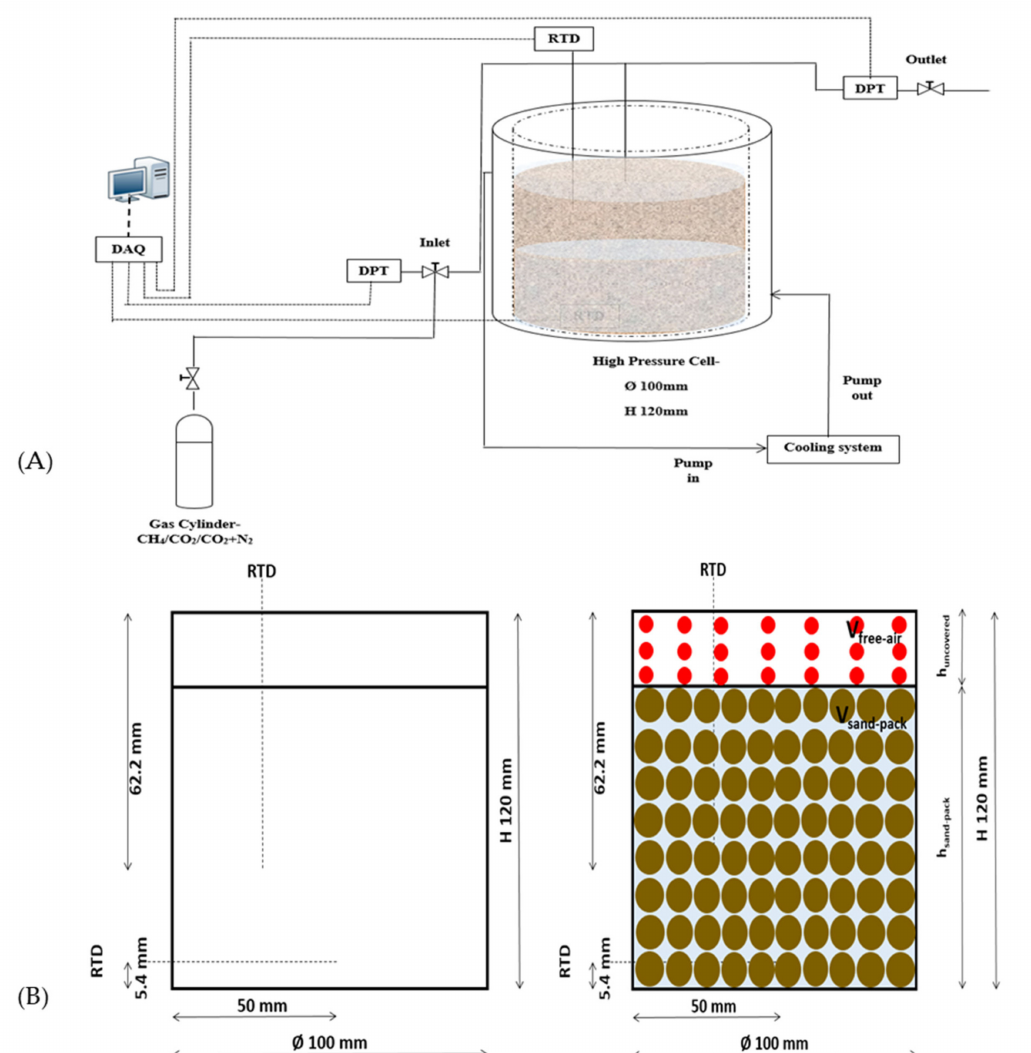
Figure 2. Schematic diagram of the high-pressure cell assembly in A and dimensioning in B. ( A ) Schematic representation of the high pressure cell and associated assembly including cooling bath, Gas injection cylinder and data acquisition system; ( B ) Figure showing the dimension of the high pressure cell and visual representation of the system’s initial